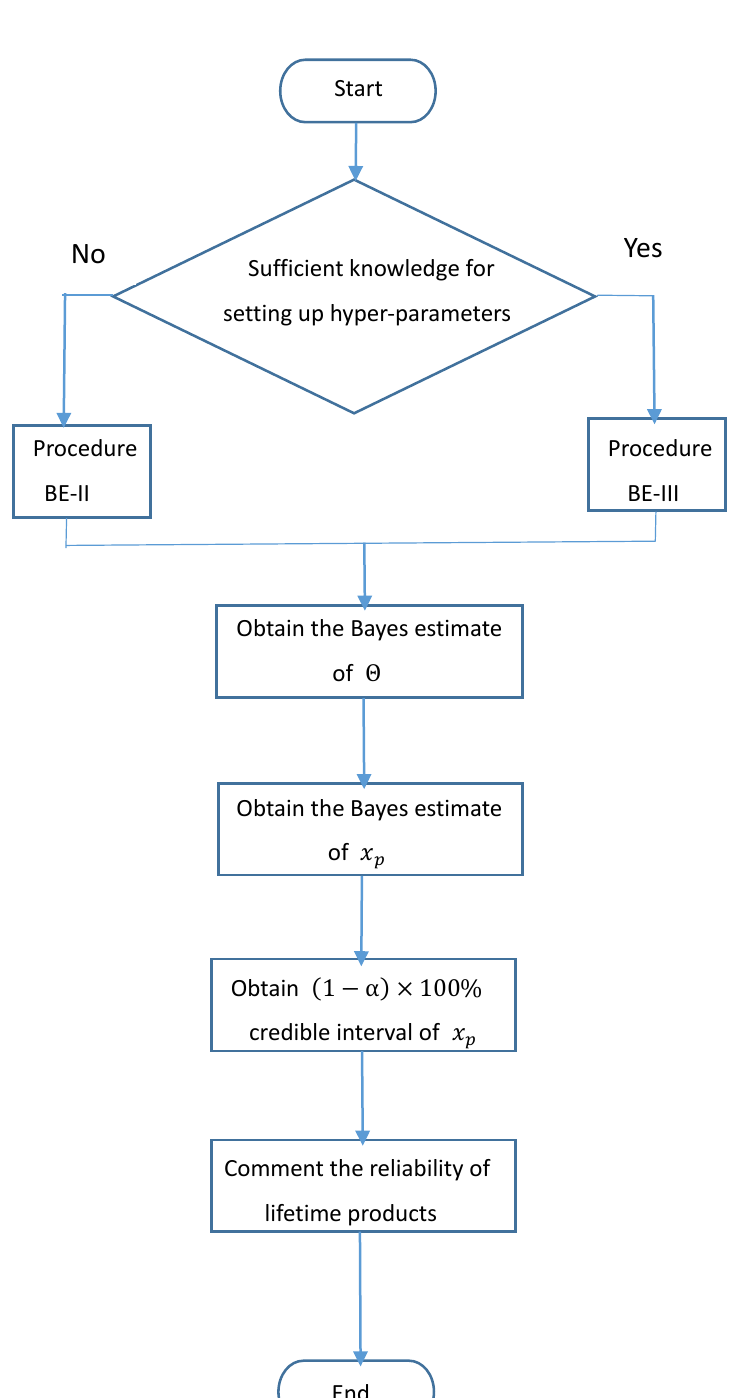
Figure 6. The flowchart for using the proposed Bayesian estimation